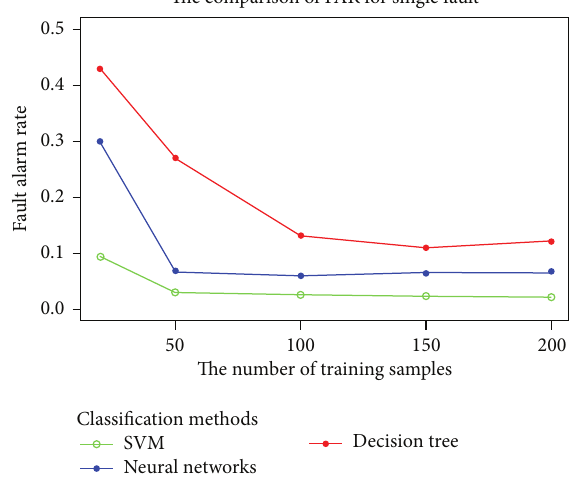
Figure 11: The FAR of three methods with small fault samples.